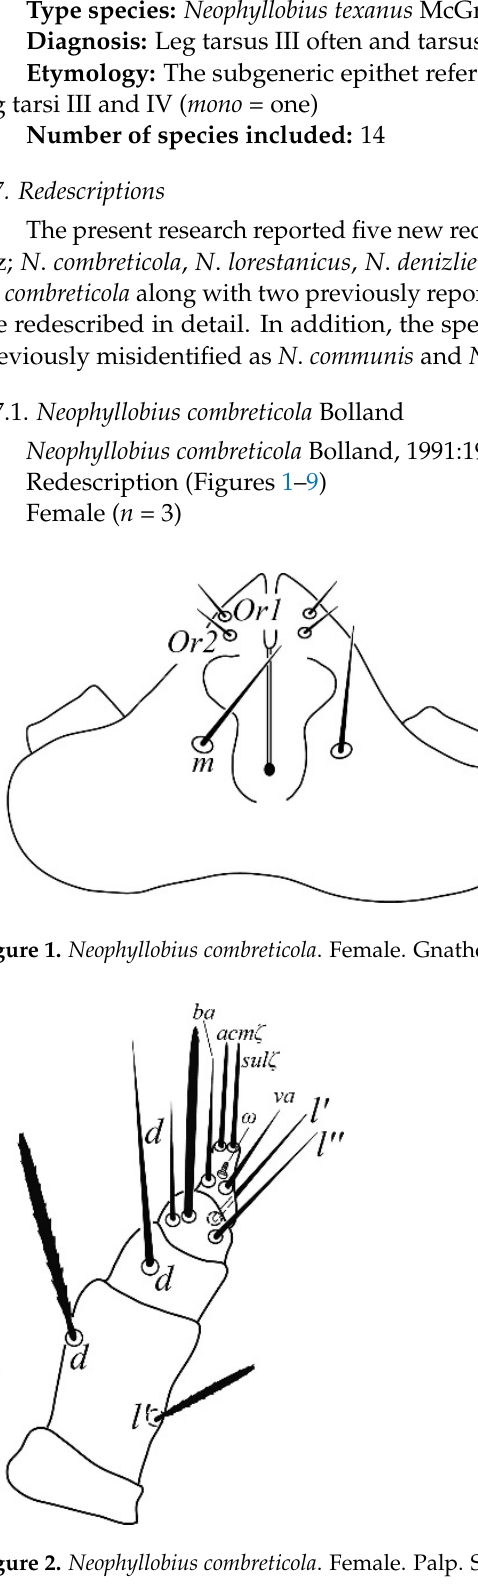
Figure 2. Neophyllobius combreticola . Female. Palp. Scale bar: 10 μ m.